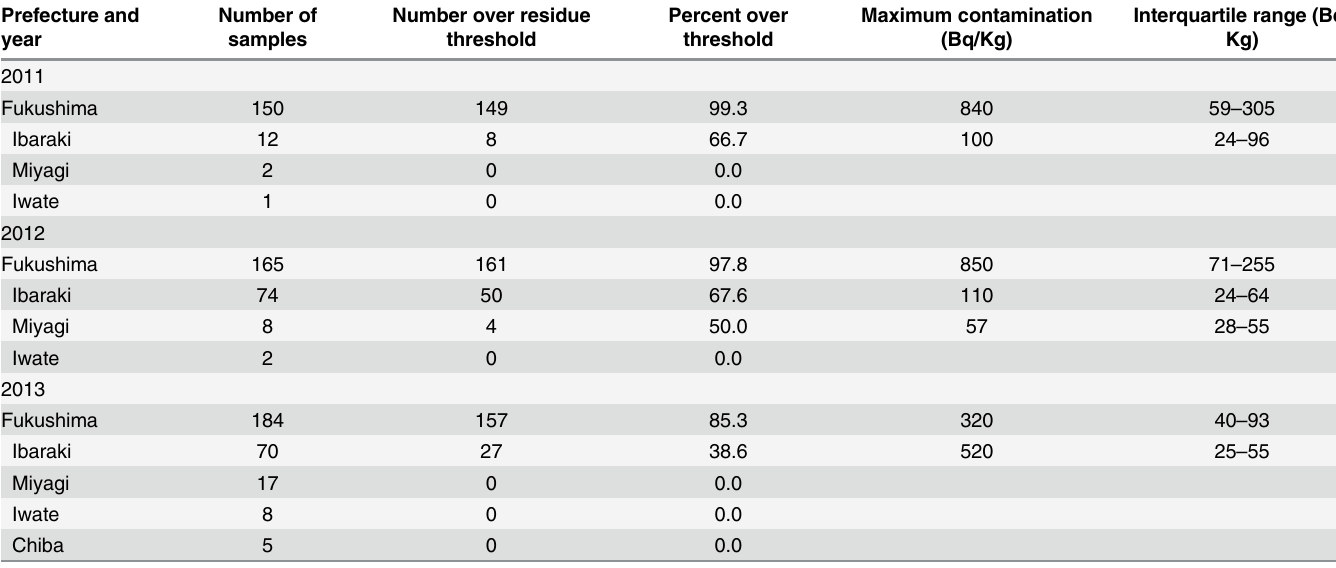
Table 3. Results of assessment of radiocontamination of Ocellate spot skate in five Prefectures, 2011 –